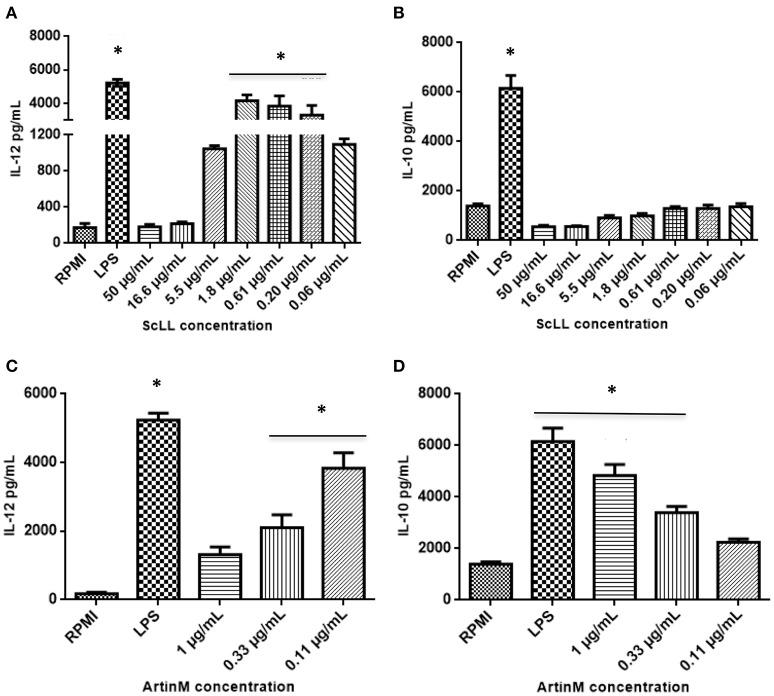
Cytokine measurements in supernatants from bone marrow-derived macrophages (BMDMs) cultures after 48 h of stimulation with different concentrations of ScLL or ArtinM. Medium alone (RPMI) or LPS (1 μg/mL) were included in all experiments, as negative and positive controls, respectively. Levels of IL-12 (A) and (C) and IL-10 (B) and (D) were determined by immunoenzymatic assay ELISA. Results are expressed as mean ± SD of cytokine levels in pg/mL. *Statistically significant in relation to the control (RPMI-1640). (ANOVA and Tukey's multiple comparison post-test; P < 0.05).